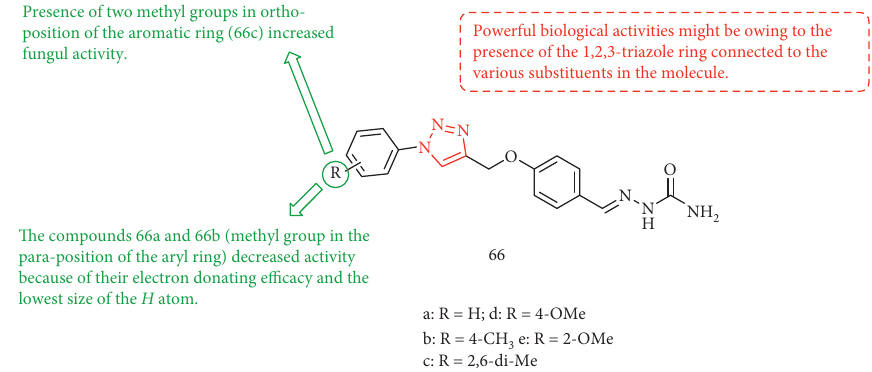
Figure 21: Chemical structure of new series of semicarbazone-triazole hybrid